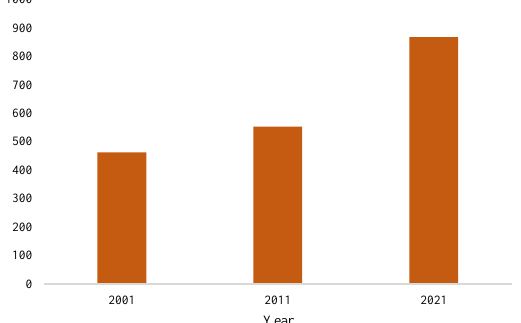
Figure 4. Column graph showing comparative vegetation change for 2001, 2011, and 2021.